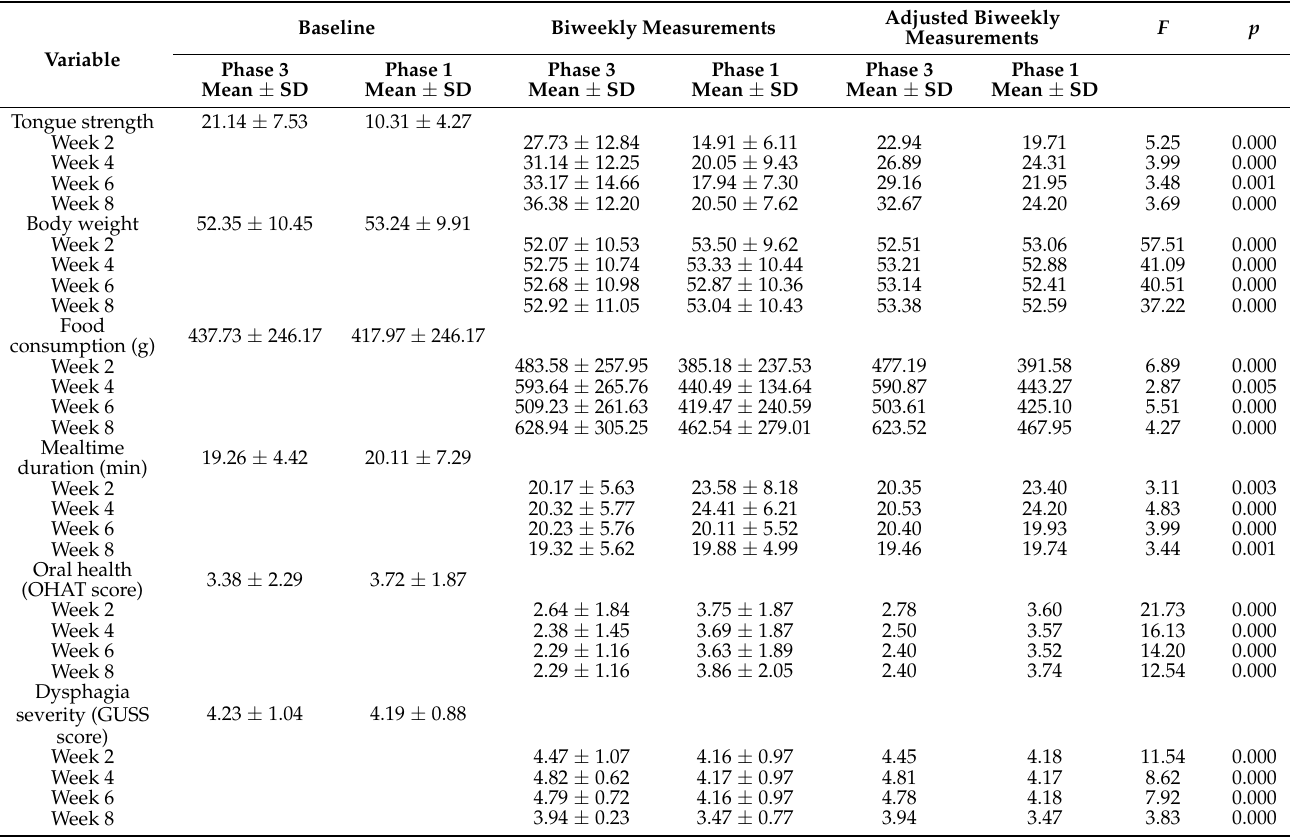
Table 4. Differences in outcome variables between phases 1 and